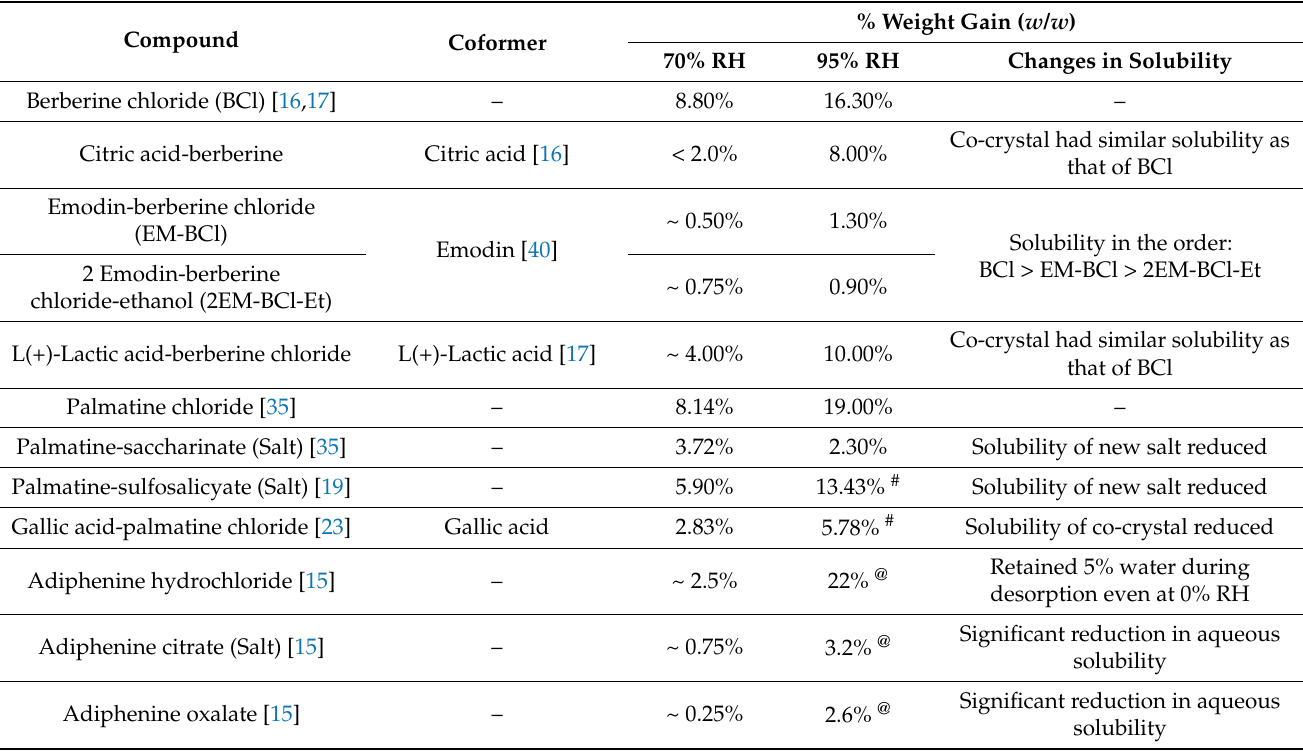
Table 3. Comparison of hygroscopic data of berberine chloride, palmatine chloride, and adiphenine hydrochloride with their co-crystals or different salt forms.